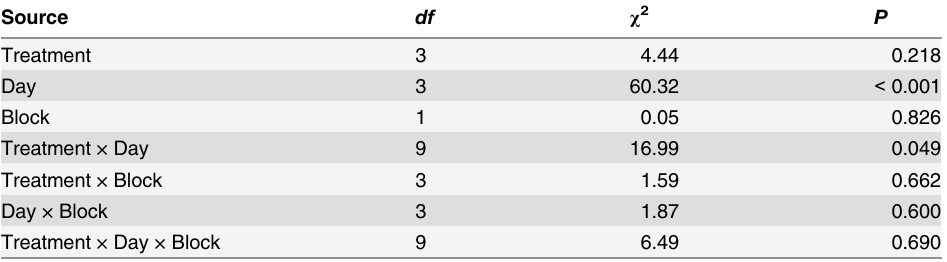
Table 3. Generalized linear model of the effects of different molecular-weight fractions of male acces- sory gland extract (treatment), the number of days after injection (days), and the experimental